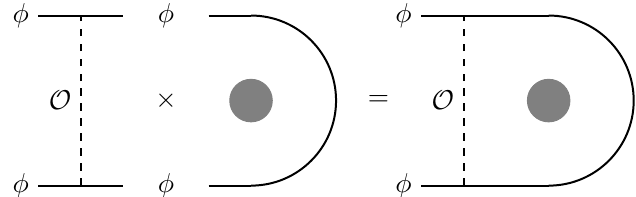
Figure 7. The diagram on the right can be thought of as the product of the two subdiagrams. Reading it from left to right, it’s comprised of the contribution of O to the anomalous dimensions of [ (cid:30)(cid:30) ] n , and the thermal coe(cid:14)cients of the [ (cid:30)(cid:30) ] n families proportional to b 1 . Accordingly, it should ((cid:22) h ) (cid:2) a ( 1 ) ((cid:22) h ) in the sum over [ (cid:30)(cid:30) ] be interpreted as the asymptotic piece with (cid:14) ( O ) 0 . [ (cid:30)(cid:30) ] n [ (cid:30)(cid:30) ] n where (cid:14) ( O ) is some coe(cid:14)cient. Now, imagine the contribution of the identity operator [ (cid:30)(cid:30) ] 0